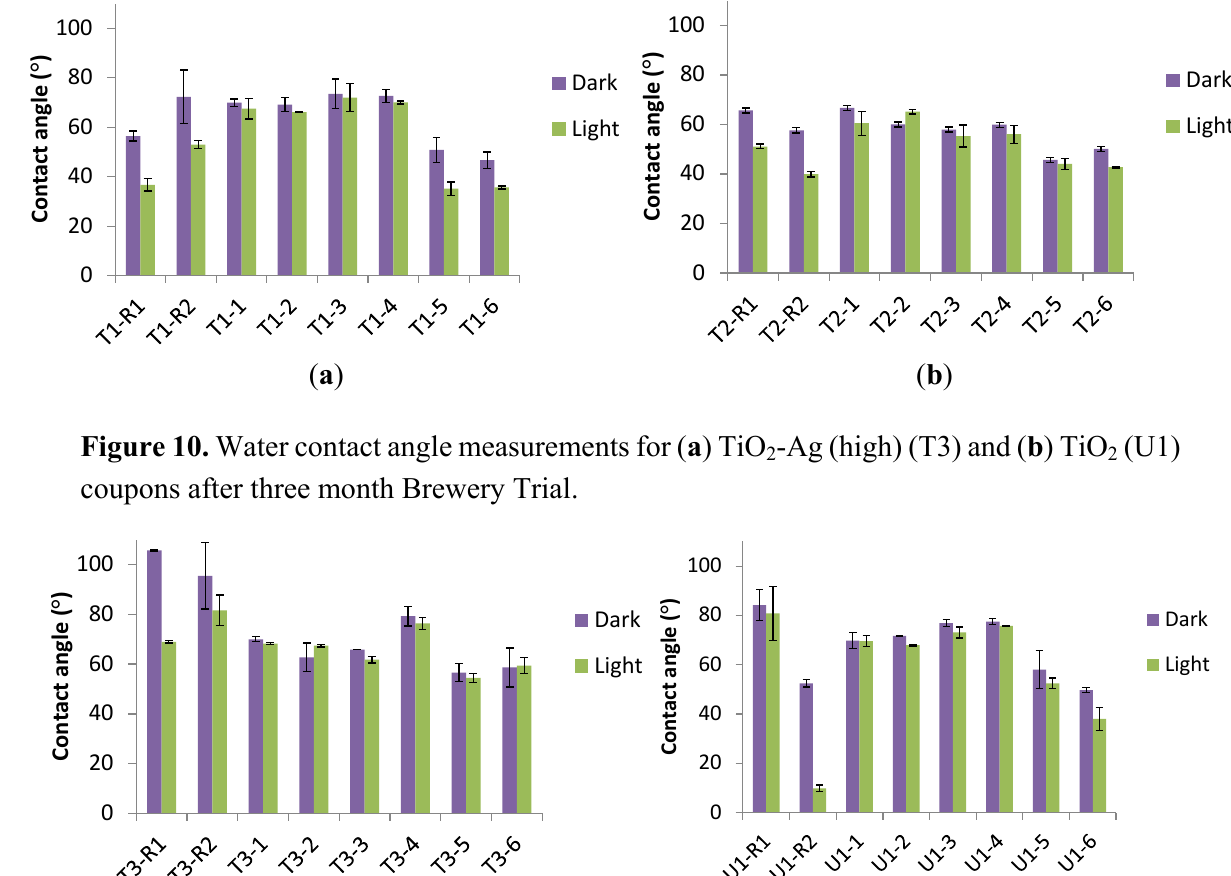
Figure 9. Water contact angle measurements for ( a ) TiO coupons after three-month Brewery Trial.